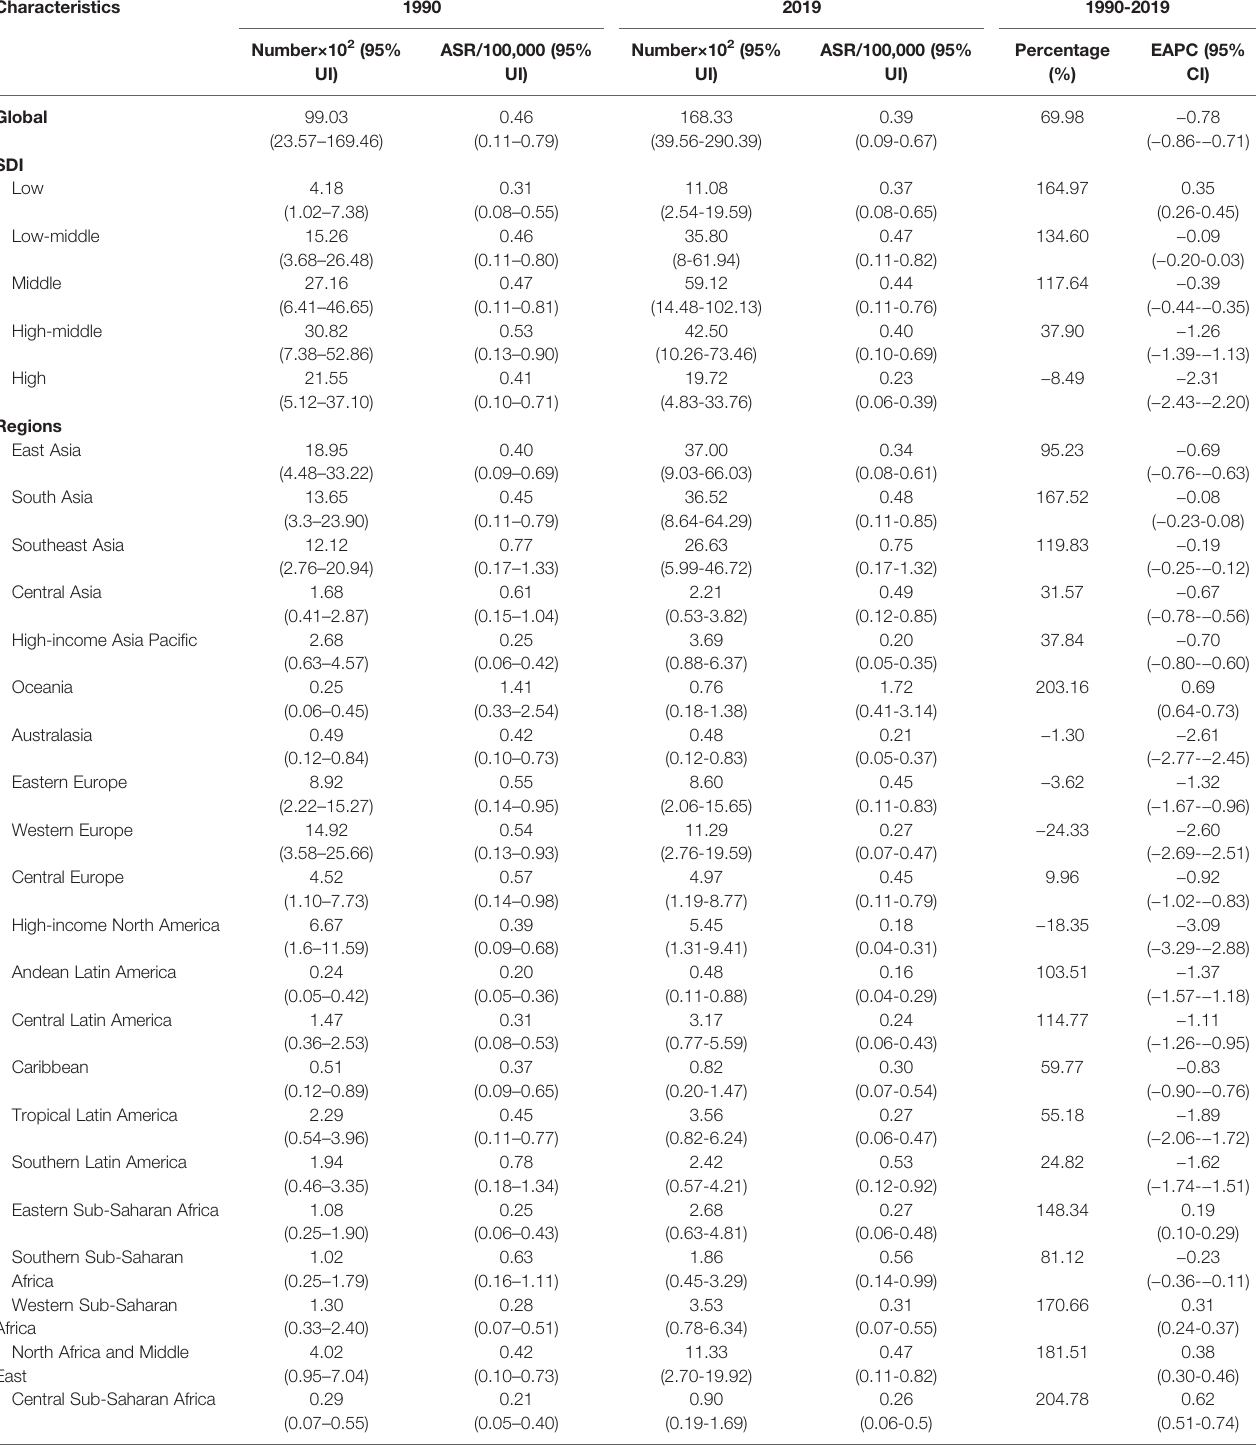
TABLE 1 | the characteristics and trends of death caused by breast cancer attributable to secondhand smoke in global, SDI areas and geographic regions, 1990-2019.